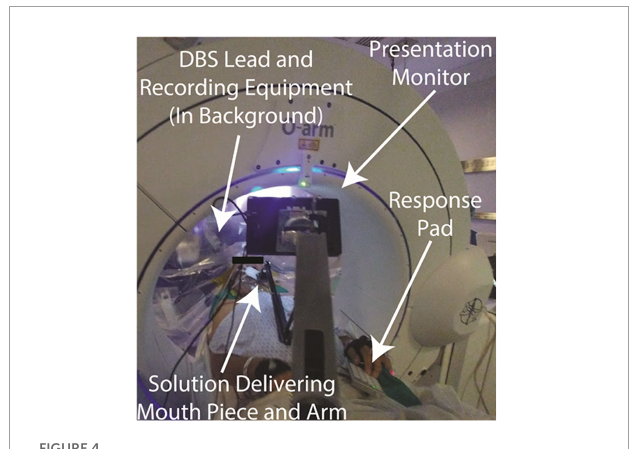
FIGURE4 Intraoperative appetition provocation